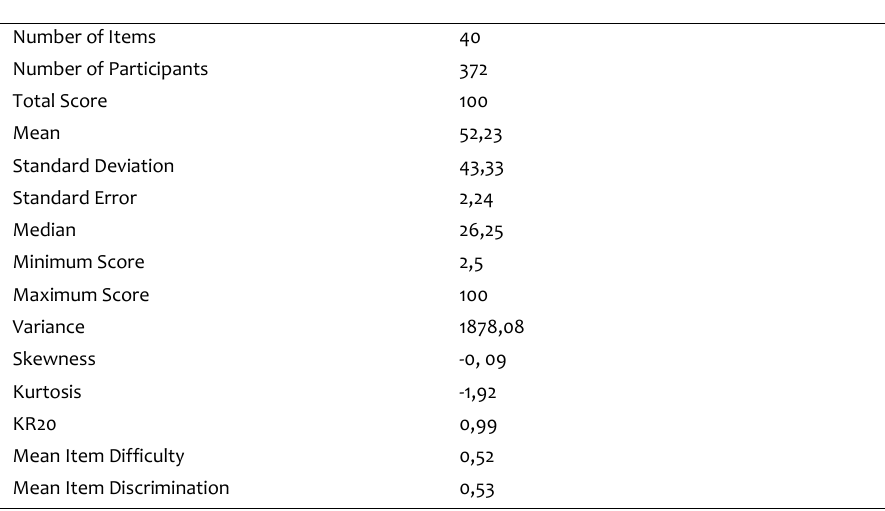
Table 4. Statistics of the Achievement Test